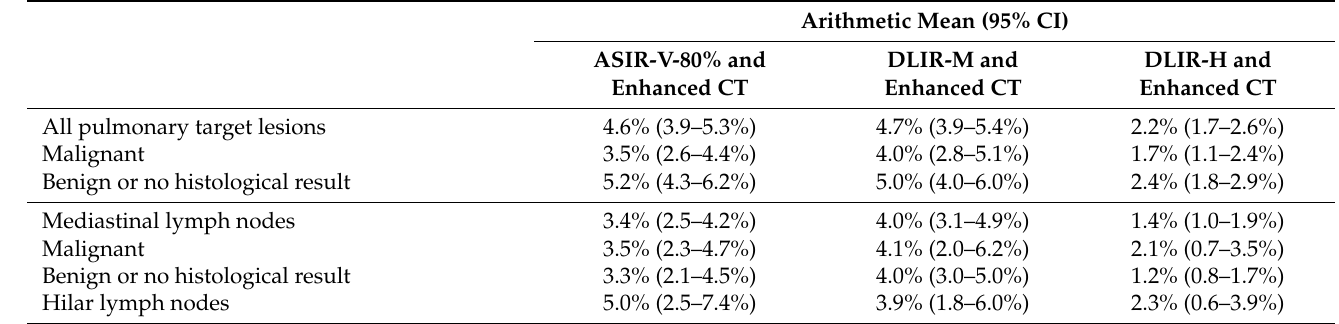
Table 3. Bland ‐ Altman analysis of measured diameter of RECIST ‐ defined measurable target lesions between ultra ‐ low ‐ dose CT and contrast ‐ enhanced CT. Table 3. Bland-Altman analysis of measured diameter of RECIST-defined measurable target lesions between ultra-low-dose CT and contrast-enhanced CT.